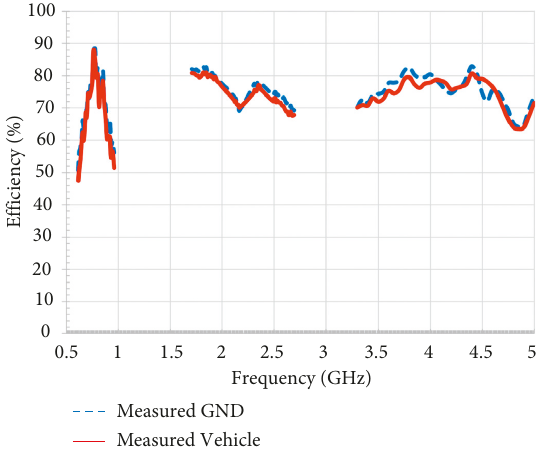
Figure 13: 5G and LTE measured efficiency on a ground plane and a vehicle.